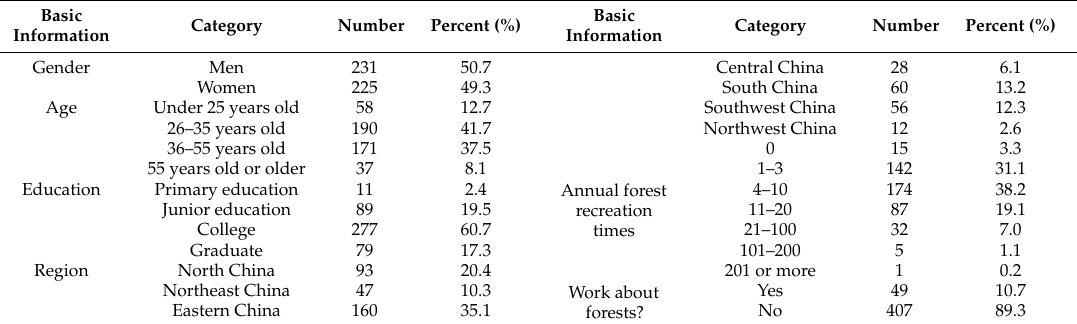
Table 2. Basic demographics of questionnaire